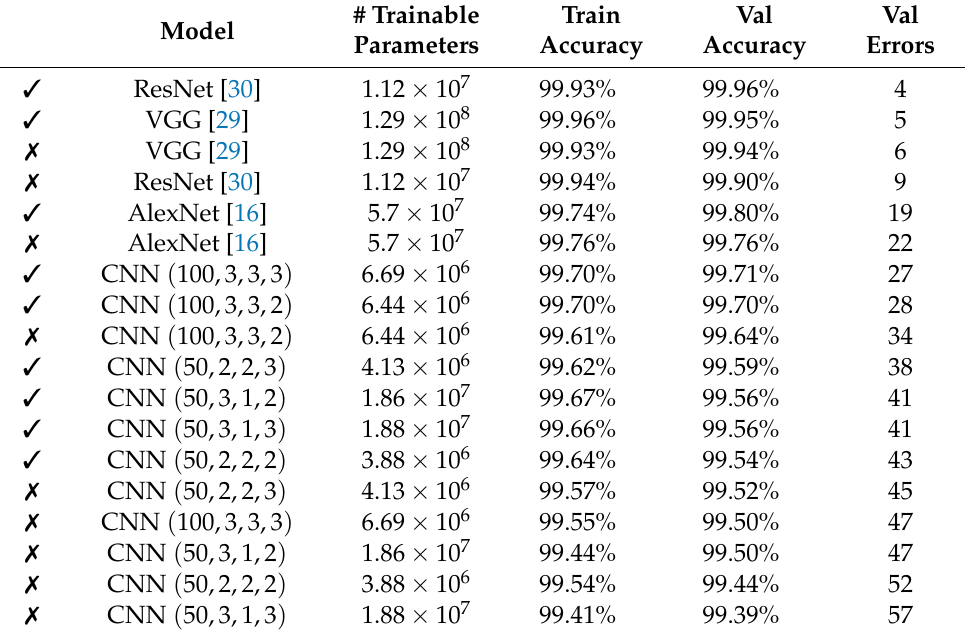
Table 1. Performance of the trained occupancy classifiers. Models prefixed with “CNN” are vanilla CNNs where the 4-tuple denotes the side length of the square input size in pixels, the number of convolution layers, the number of pooling layers, and the number of fully connected layers. The check mark in the left column indicates whether the input samples contained contextual information (cropped to include part of the adjacent squares). We report the total number of misclassifications on the validation set (consisting of 9346 samples) in the last column. The differences between training and validation accuracies indicate no overfitting.